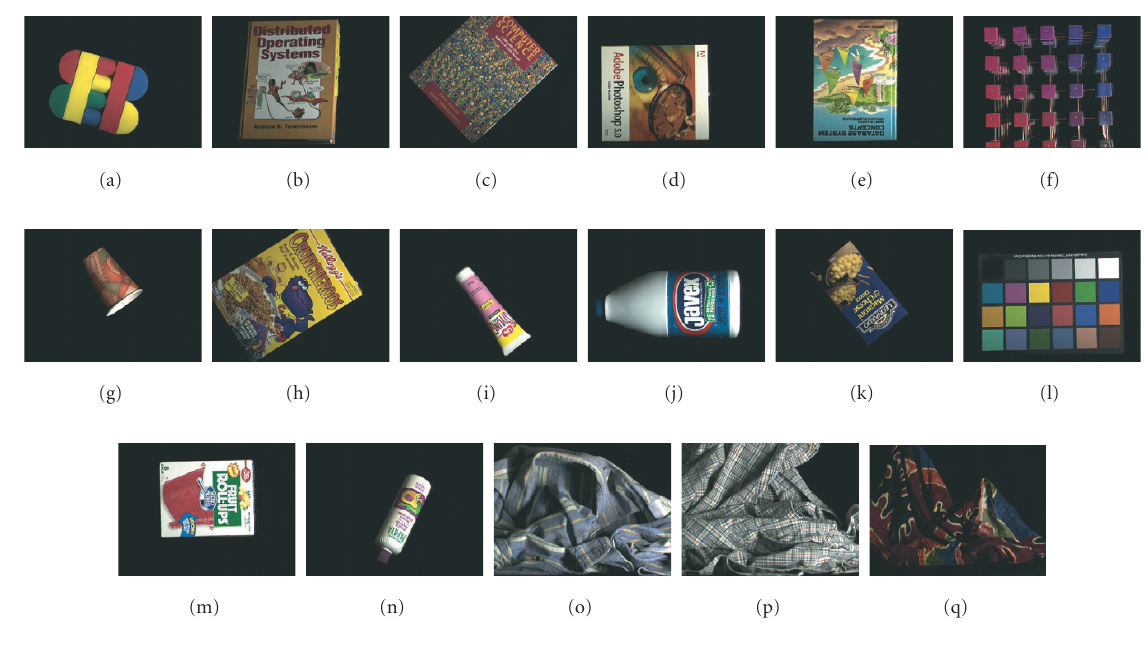
Figure 2: The 17 objects of the SFU database. Table 3: Object recognition results obtained by the intersections between di ff erent histograms with the SFU database. Intersection between ( N = 16) ( N = 64) ( N = 256) Invariant color histograms